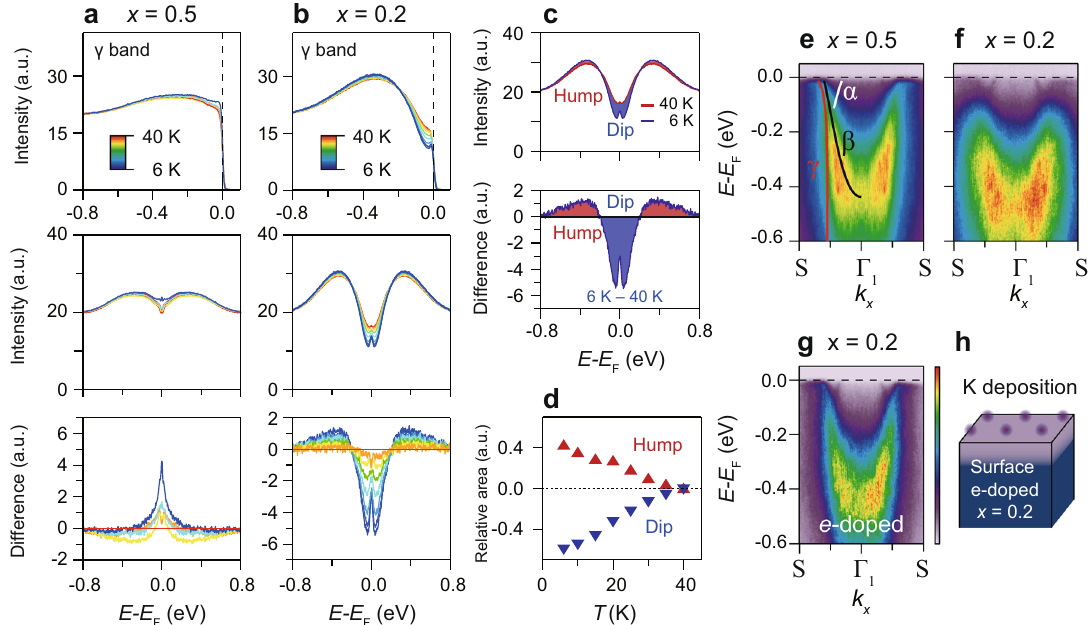
Fig. 3 Spectral weight transfer and breakdown of the orbital-selective Mott phase (OSMP) upon K deposition. Normalised T -dependent energy distribution curves (EDCs) (top), symmetrised EDCs (middle) and after subtraction of the 40 K data (bottom) for x = a 0.5 and b 0.2. The EDCs are extracted from a region near the S-point, integrated over 0.6 ≤ k x ≤ 0.8 (for the raw data, see Supplementary Fig. 2). c The symmetrised EDCs of T = 6, 40 K in b (top) and their difference (bottom). The ‘ dip ’ and ‘ hump ’ are de fi ned as the area in 0 ≤ BE(eV) ≤ 0.2 and 0.2 ≤ BE(eV) ≤ 0.8 regions, respectively. d T -dependent areas of the ‘ dip ’ and ‘ hump ’ . e – g ARPES images (right) and corresponding 2D curvature plots 50 (left) along S- Γ 1 -S for x = e 0.5, f 0.2, and g x = 0.2 with an electron doping value of 0.02 measured at T = 10 K using σ -polarised light. Solid white/black/red guidelines indicate the dispersions of α -/ β -/ γ -bands, respectively (Supplementary Fig. 7). For g , 0.2 monolayer of K coverage was deposited in situ on the surface of Ca 2-x Sr x RuO 4 ( x = 0.2) to achieve electron doping effect lightly (about 0.02 electrons, Supplementary Fig. 8) h Schematic illustration of alkali metal (potassium K) deposition on the surface of a Ca 2-x Sr x RuO 4 ( x = 0.2) single